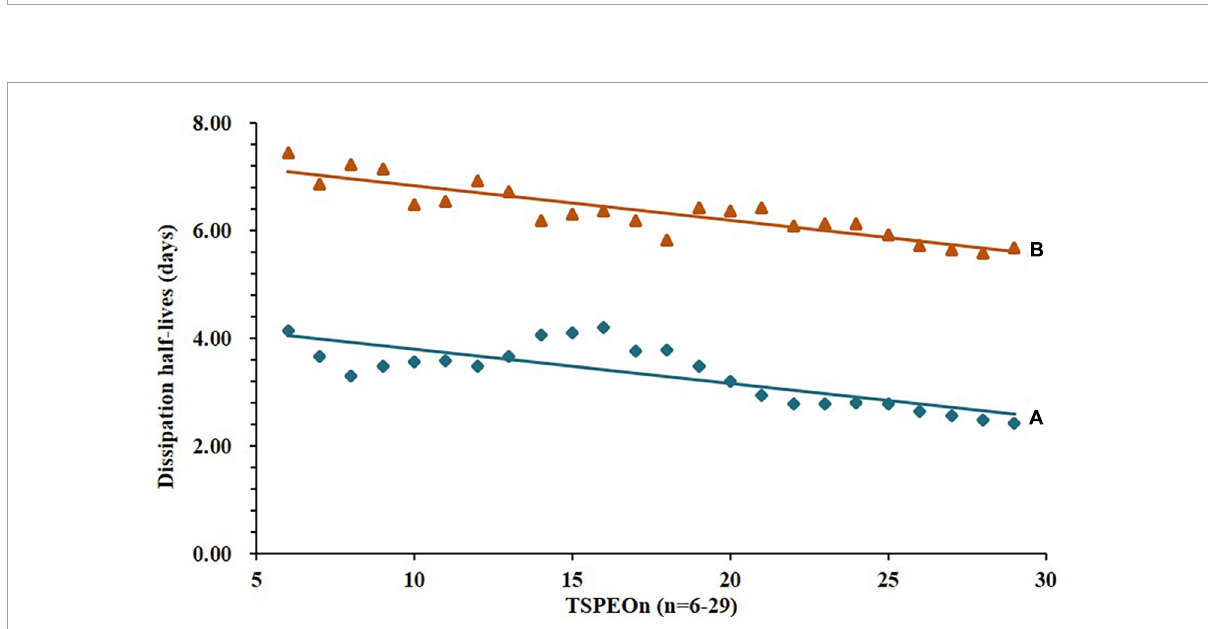
FIGURE4 Relationship between dissipation half-lives and the different homolog tristyrylphenol ethoxylates (TSPEOn) ( n = 6–29) in cowpea and soil. (A) TSPEOn half-lives in cowpea, slope = –0.0632, r 2 = 0.6247; (B) TSPEOn half-lives in soil, slope = –0.0644, r 2 =